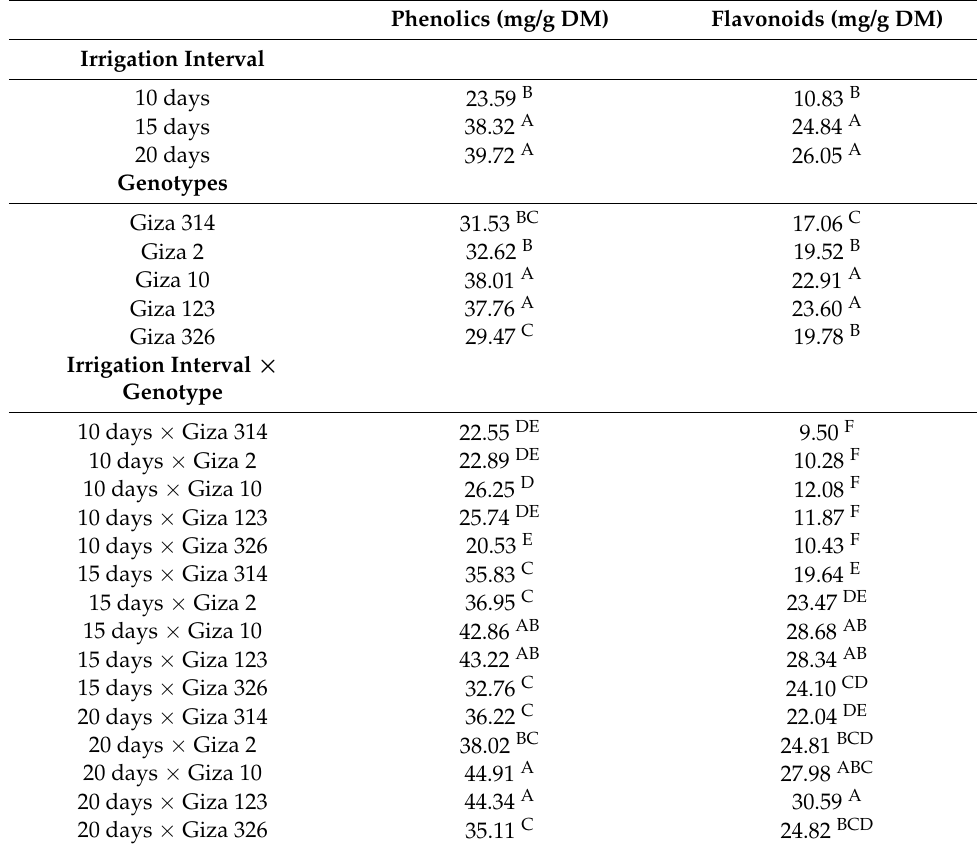
Table 6. Non-enzymatic antioxidants of five maize genotypes as affected by normal (10 days), mild (15 days), and severe (20 days) water stress at the vegetative stage. Means within the same column distinguished by different letters differ significantly according to the Tukey’s posthoc HSD test at p =